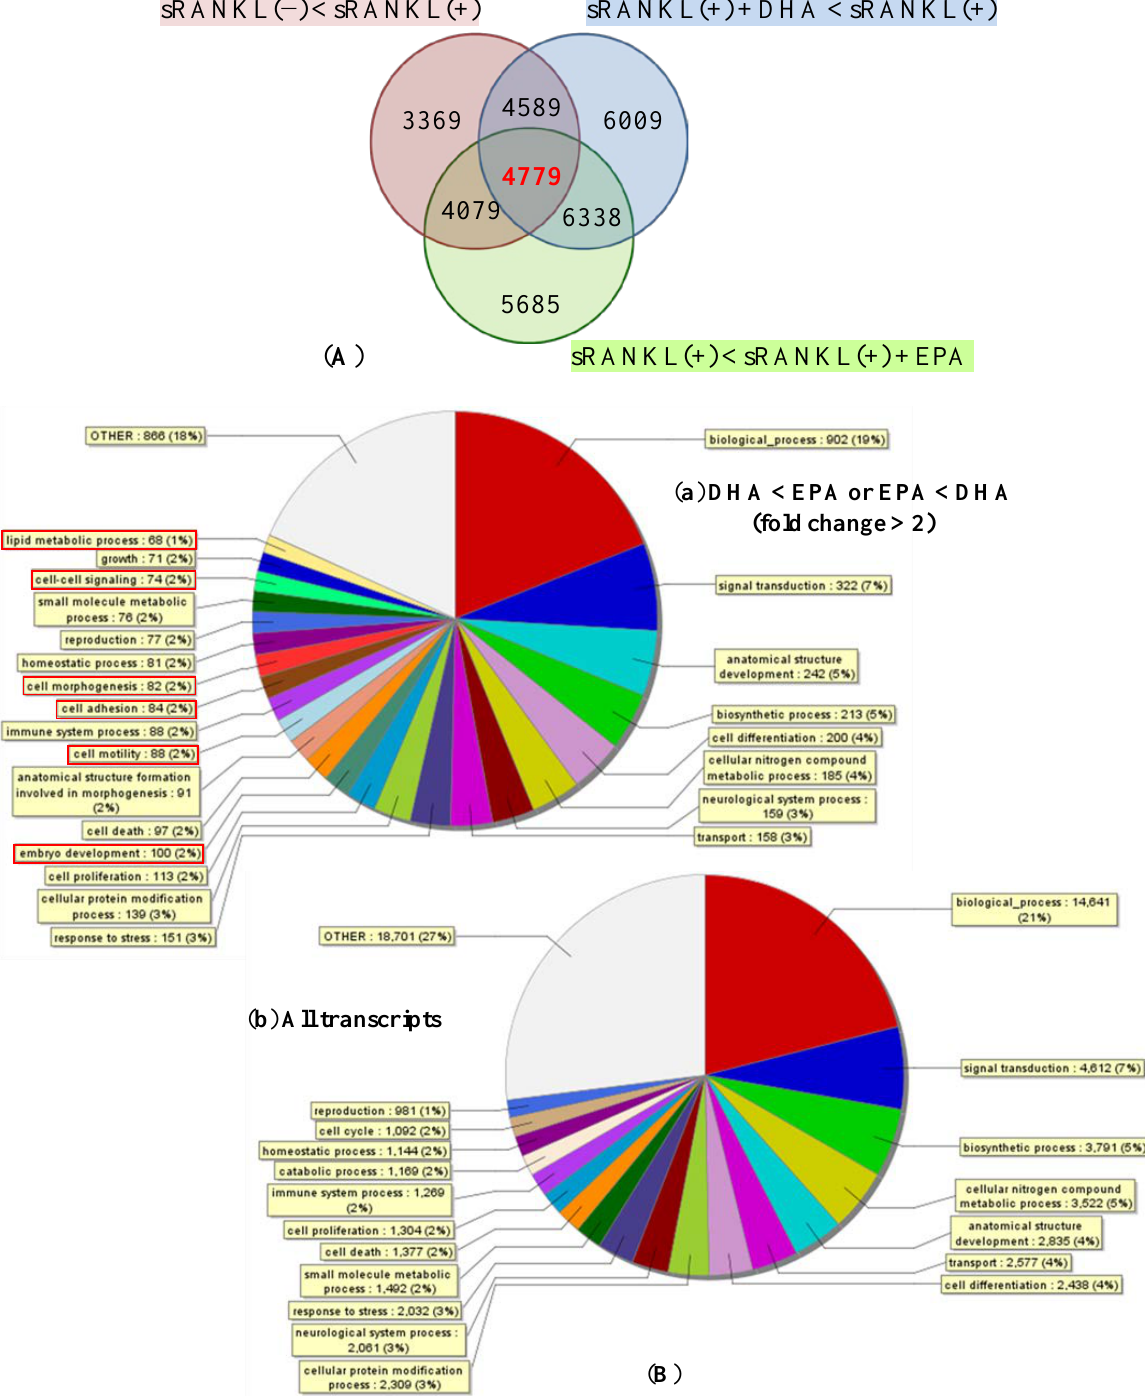
Figure 4. Genes significantly affected by the DHA or EPA treatment. ( A ) The Venn diagram shows the grouping of genes with at least two-fold changes. The numbers in the diagram indicate the number of genes. The red circle include genes that were upregulated by sRANKL(+) compared with sRANKL(−), the blue circle include genes that were downregulated by DHA + sRANKL(+) compared with sRANKL(+) and the green circle include genes that were upregulated by sRANKL(+) + EPA compared with sRANKL(+). ( B ) The pie chart shows GO slim annotation of the differentially expressed transcripts between DHA and EPA ( a ). All transcripts were shown in ( b